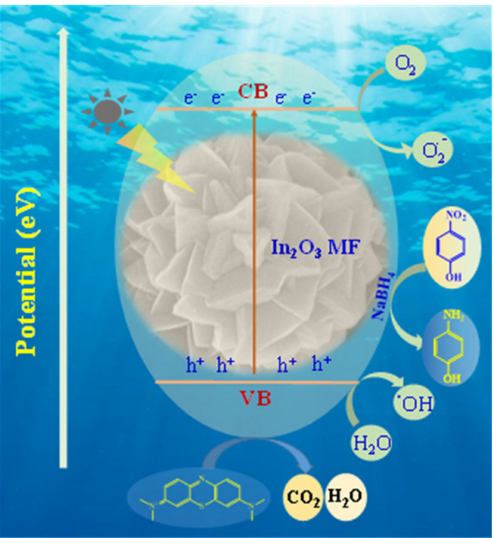
Figure 10. Proposed photocatalytic mechanism of reduction and degradation of 4-NP and MB by In 2 O 3 -MF